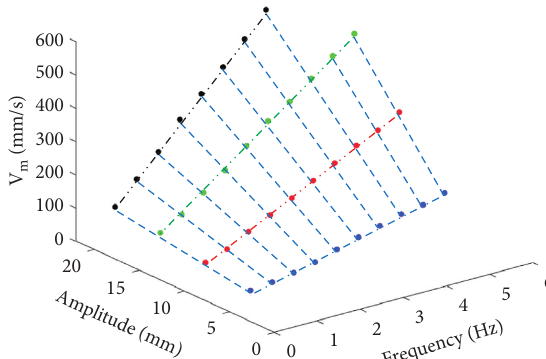
Figure 12: The relationship between maximum velocity and excitation